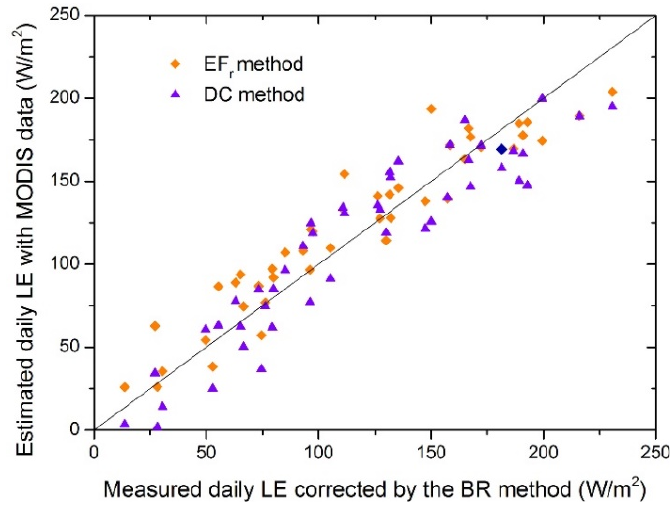
Figure 7. Validations of daily ET estimations calculated directly by the DC method and temporal upscaled by the EFr method, based on MODIS data against with corrected ET measurements by the BR scheme.